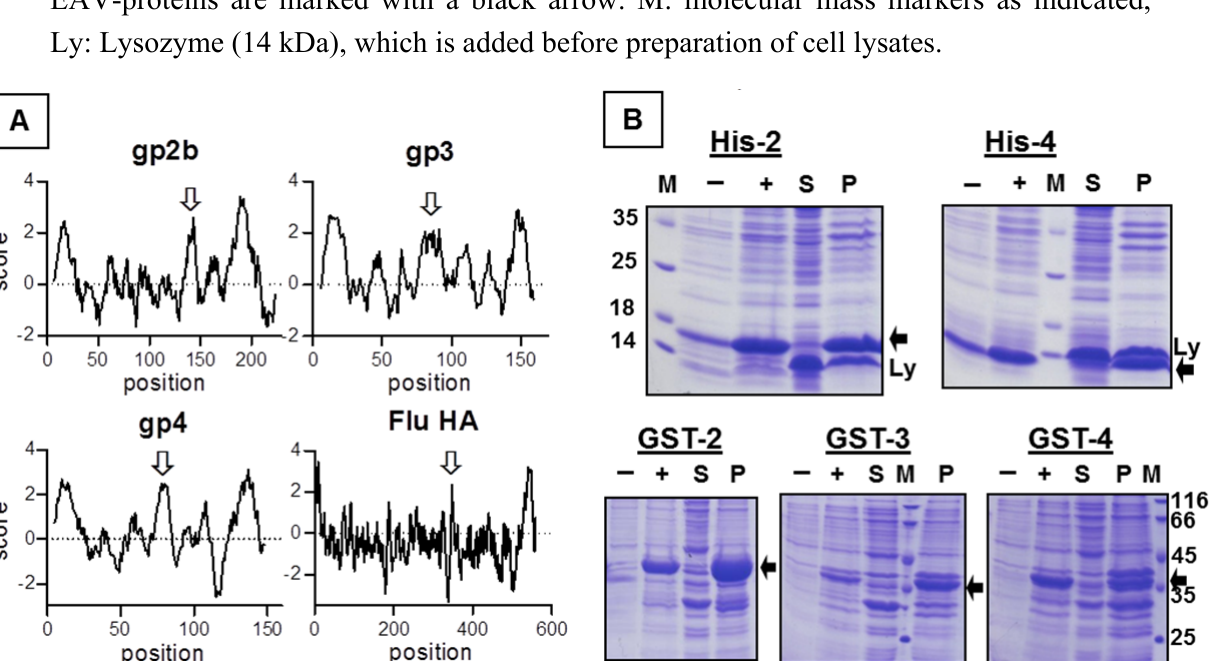
EAV-proteins are marked with a black arrow. M: molecular mass markers as